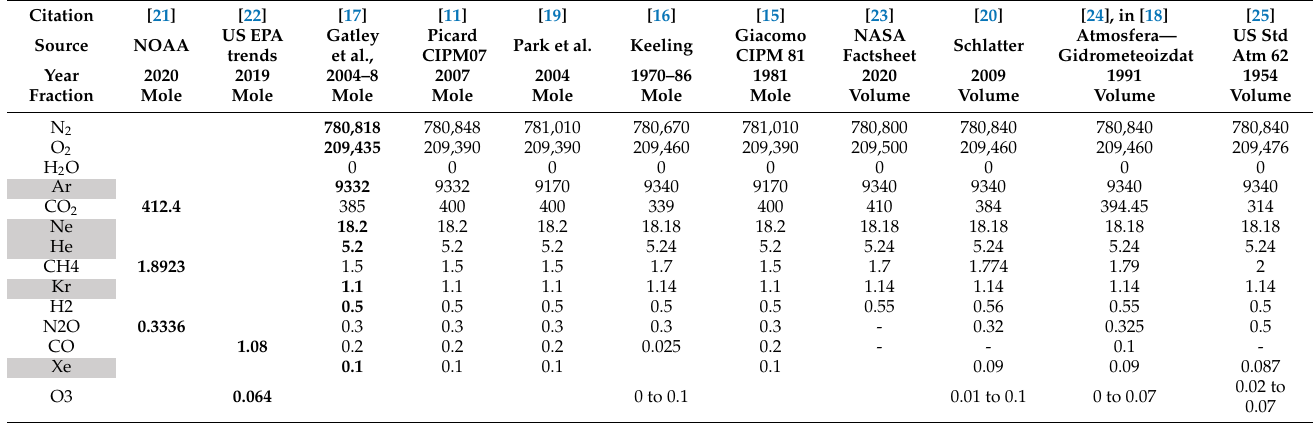
Table 1. Molar and volumetric fractions of gases in dry air at the sea level in ppm. In bold are the latest values, which were used for the final values.